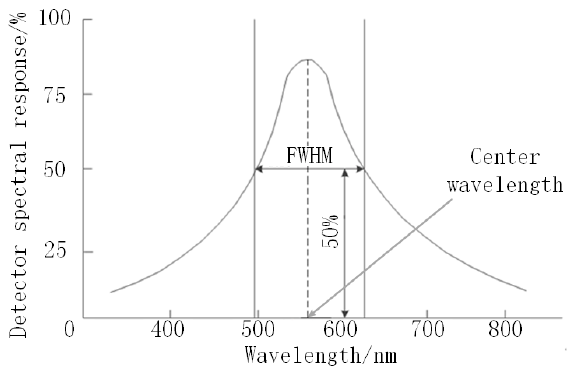
Figure 1. The principle of the spectral response function.